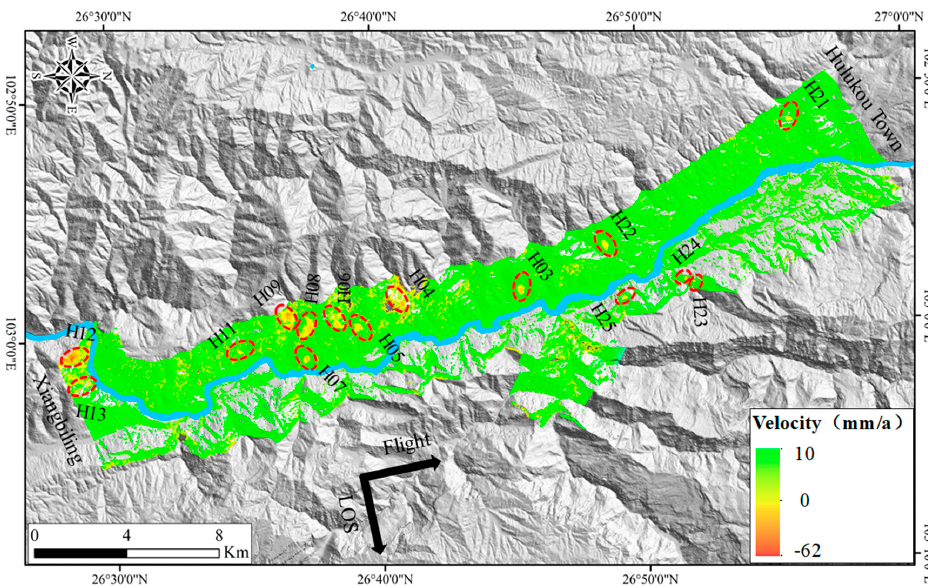
Figure 16. Effective deformation results of Sentinel-1A descending data in the study area.